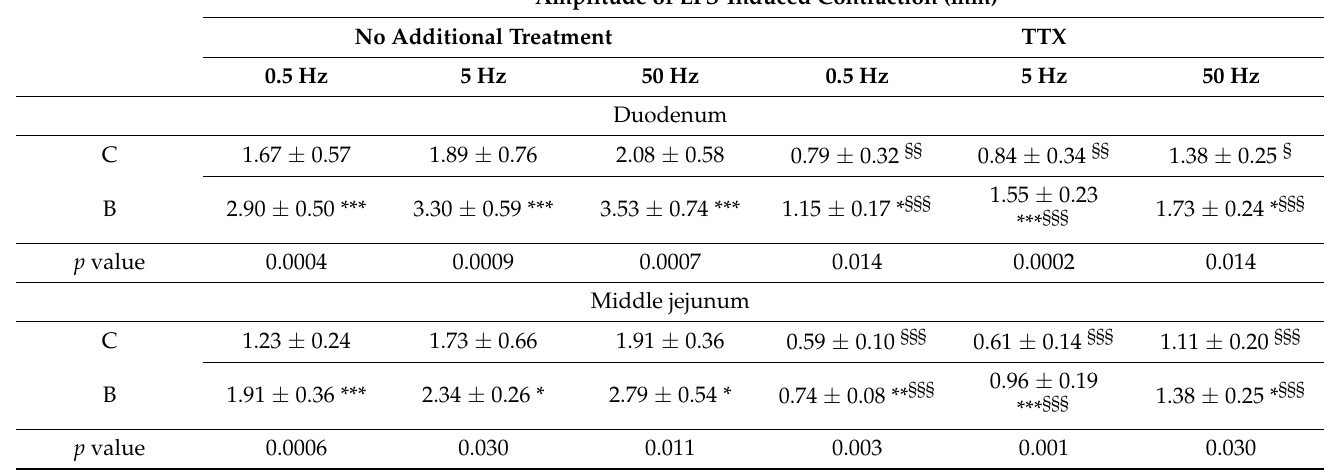
Table 1. Electrical field stimulation (EFS) induced amplitude of contraction (mm) in the presence or absence of tetrodotoxin (TTX (10 − 6 M)) in duodenal and middle jejunum fragments in control (C) and sodium-butyrate-treated piglets (B). Values are given as means ± SD; * indicates statistical differences between groups when * p < 0.05, ** p < 0.01, *** p < 0.001; § indicates statistical differences between groups in the presence of TTX when § p < 0.05, §§ p < 0.01, §§§ p < 0.001. Amplitude of EFS-Induced Contraction (mm)